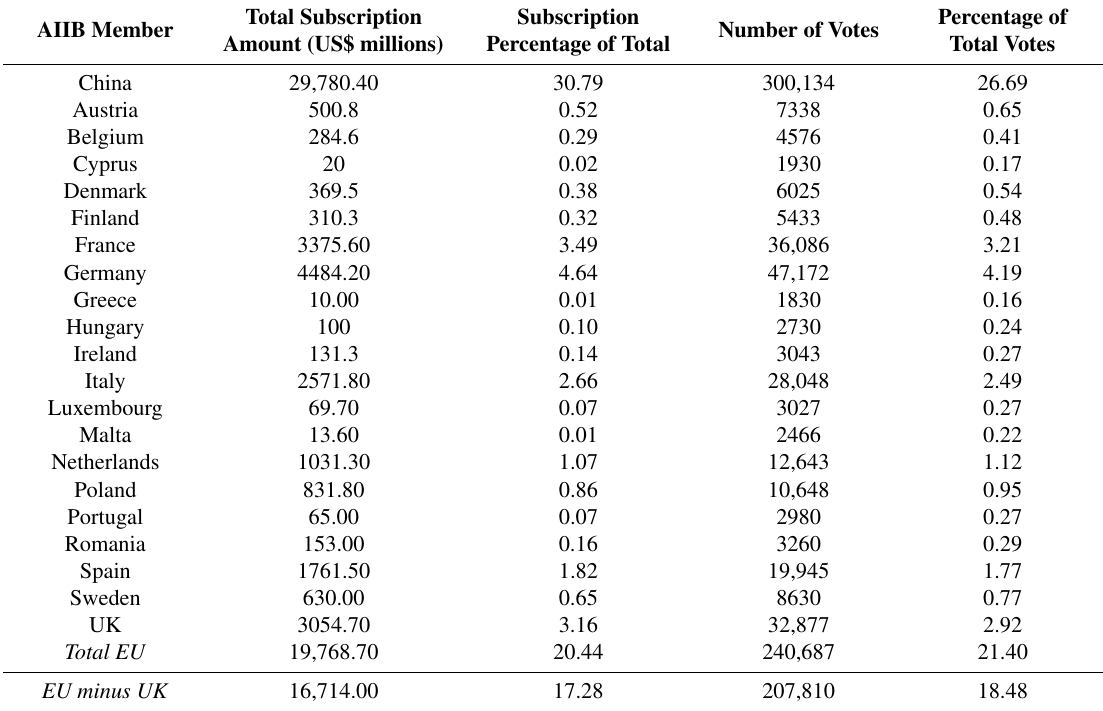
AIIB subscriptions and voting